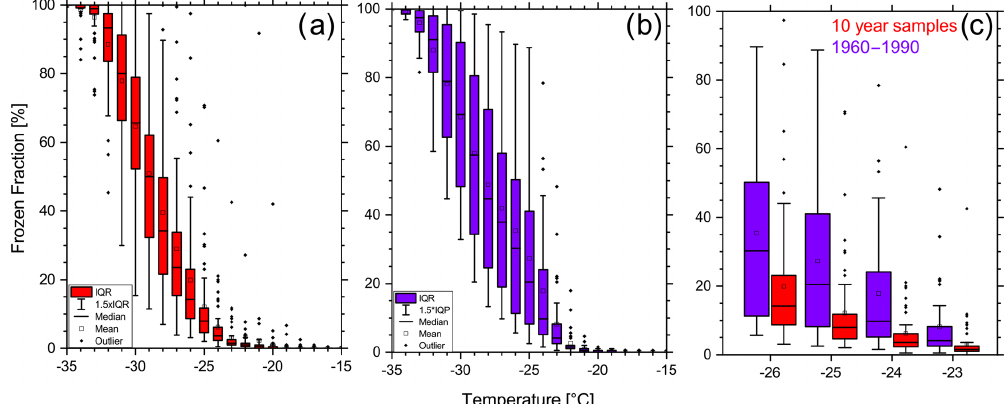
Figure 8. Box–whisker plots of the frozen fraction of the 10-year samples (a) and the modern-day samples (b) for the complete temperature range and a detailed comparison of both data sets at medium supercooled temperatures (c) .